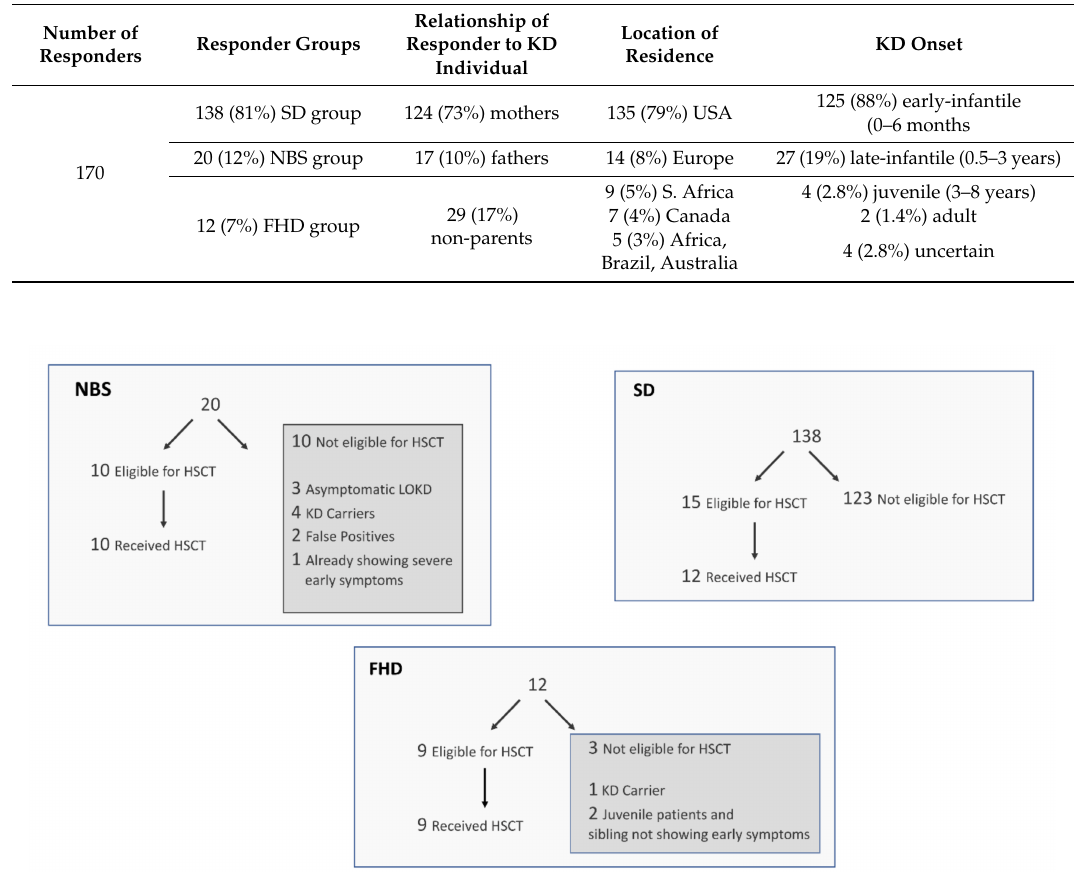
Figure 1. Eligibility of patients to receive a transplant and whether families opted for this treatment for the NBS, SD, and FHD groups (see text for discussion). HSCT—hematopoietic stem cell transplantation; LOKD—late-onset Krabbe